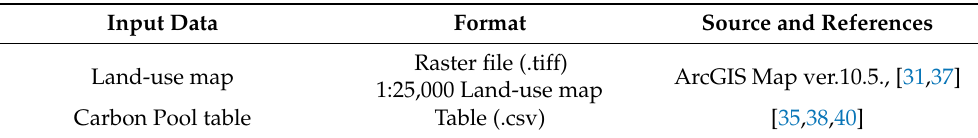
Figure 2. InVEST Carbon model process. Table 3. Input data and Format of InVEST Carbon model.